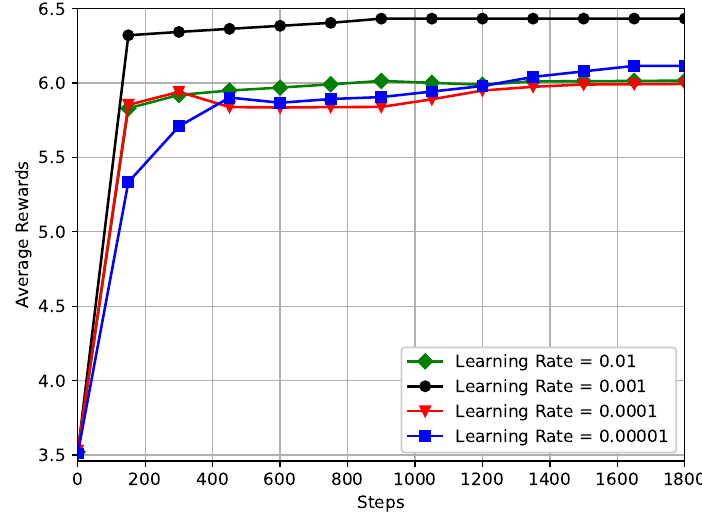
Figure 4. Variation of average reward under different learning